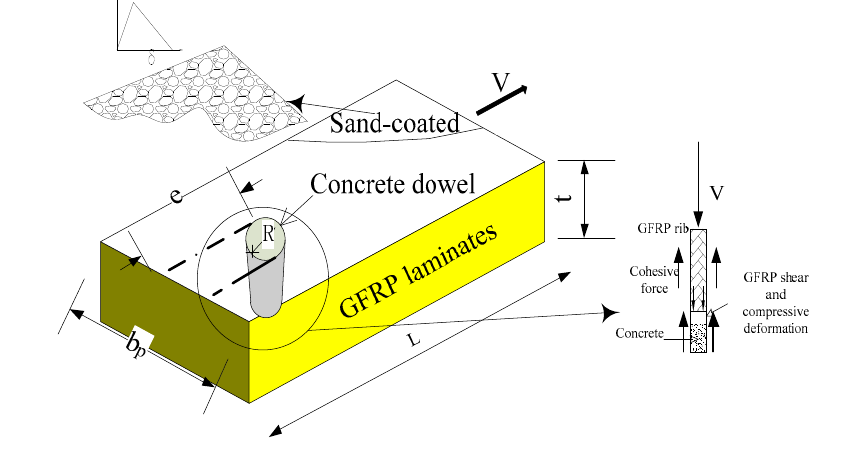
Figure 16. Failure scheme of SCGPC. Table 6. Validation of the empirical